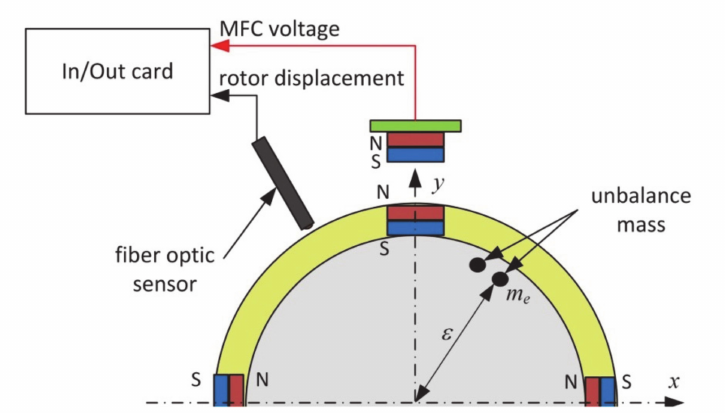
Figure 17. Rotor radial vibration measurement set-up.